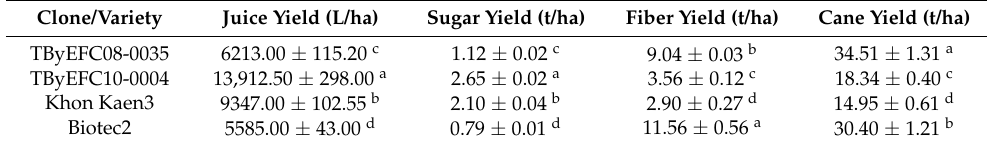
Table 3. Agronomic characteristics of energy cane clones and control